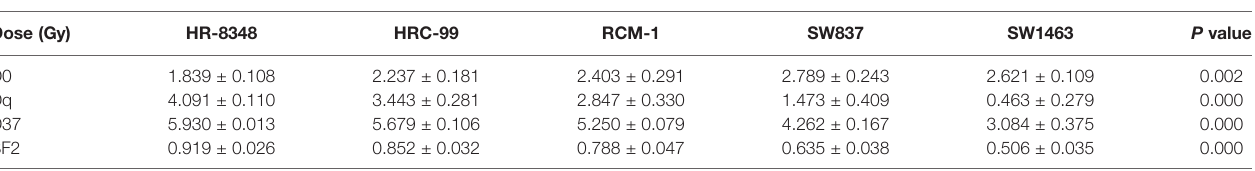
TABLE 2 | Related parameters of cell survival curve standard model. Dose